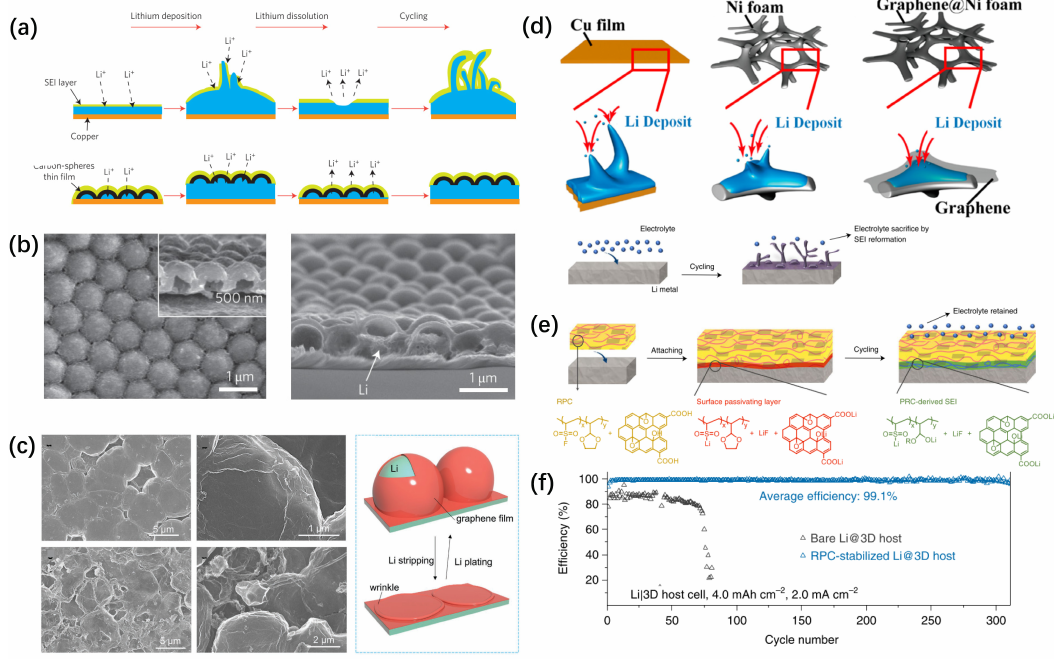
Figure 8. ( a ) Schematic illustration of the deposition of lithium metal in the presence of a stable SEI layer created by the hollow carbon nanosphere layer-modified copper substrate. ( b ) SEM image of hollow carbon nanospheres after initial SEI formation [37]. ( c ) Morphological changes and schematic diagrams of graphene films on Li metal anodes [88]. ( d ) Schematic illustration of Li deposition on bare copper foil, nickel foam, and 3D graphene@Ni foam. ( e ) Schematic illustration of molecular-level design of polymer-inorganic SEI using reactive polymer composites [89]. ( f ) Efficiency of Li|Cu 3D cells with RPC artificial SEI protection at a capacity of 4.0 mA h cm −2 [35].